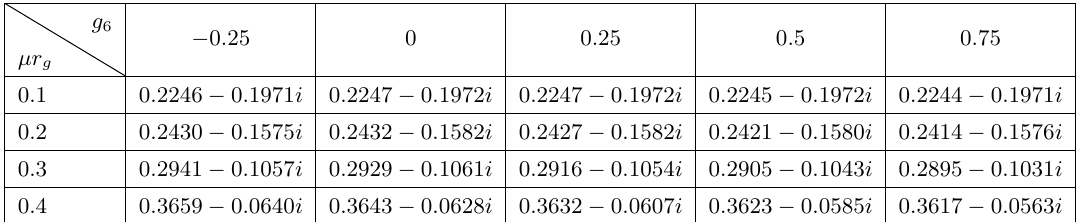
Table 2 . Frequencies ωr g of the fundamental ( n = 0) monopole QNMs.